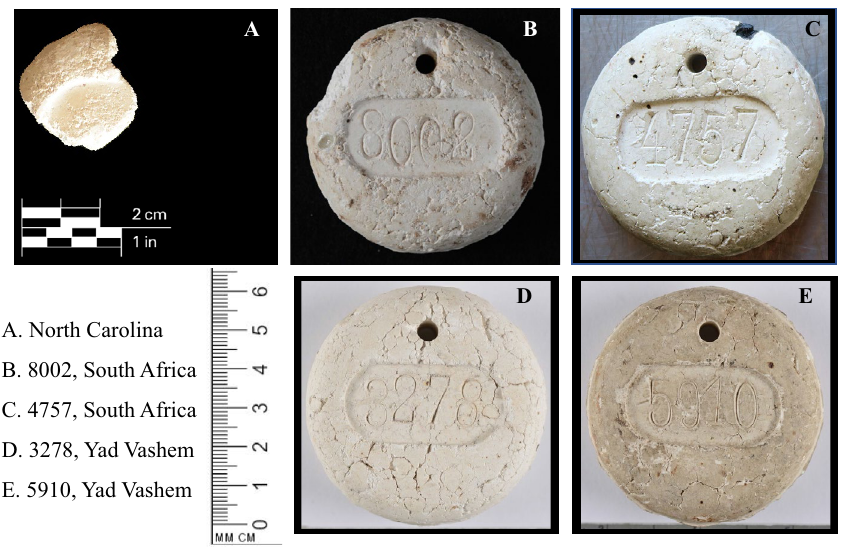
Figure 1. Images of disks analyzed by the NYC